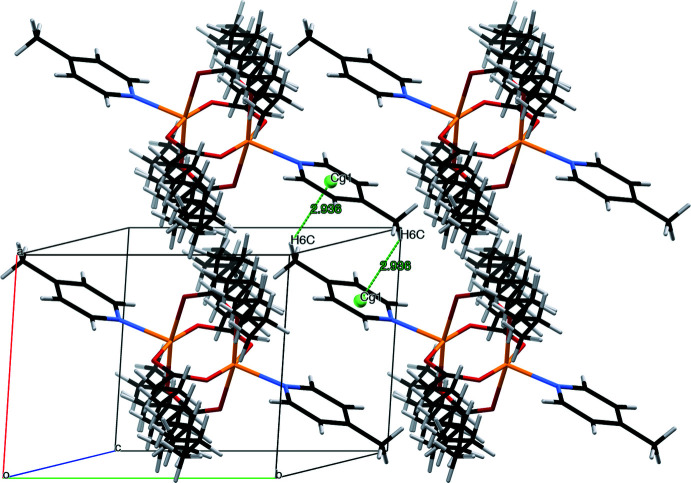
C6—H6C⋯π inter­actions in [Cu2(μ-O2CC9H19)4(4-Mepy)2] (disorder not shown)